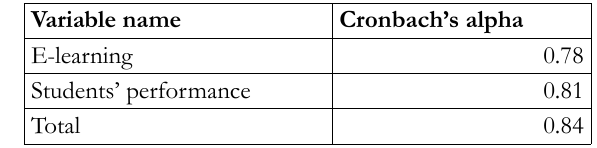
Table 3. Cronbach’s